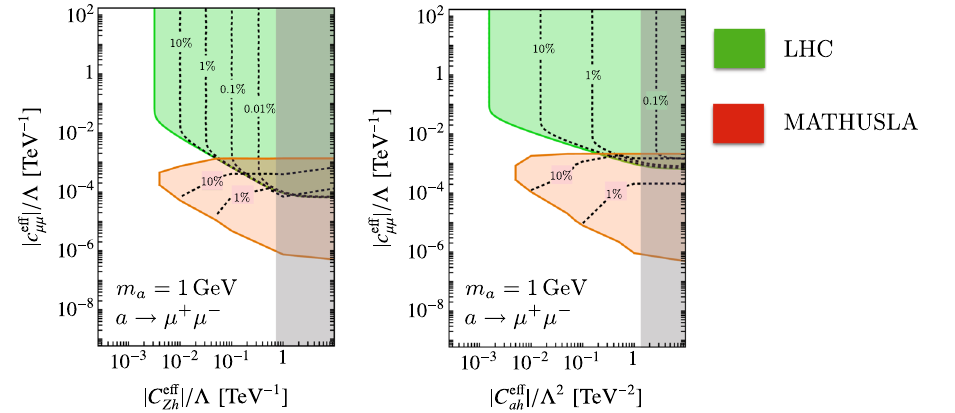
Fig. 20 Projected reach in searches for Z → γ a → 3 γ with MATHUSLA for √ s = 14TeV center-of-mass energy, 3ab − 1 integrated luminosity and Br ( a → γγ) = 1, together with the expected sensitivity of FASER taken from [104] and SHiP [20]. The sensitivity regions are based on 4 (MATHUSLA) and 100 (LHC) expected signal events,